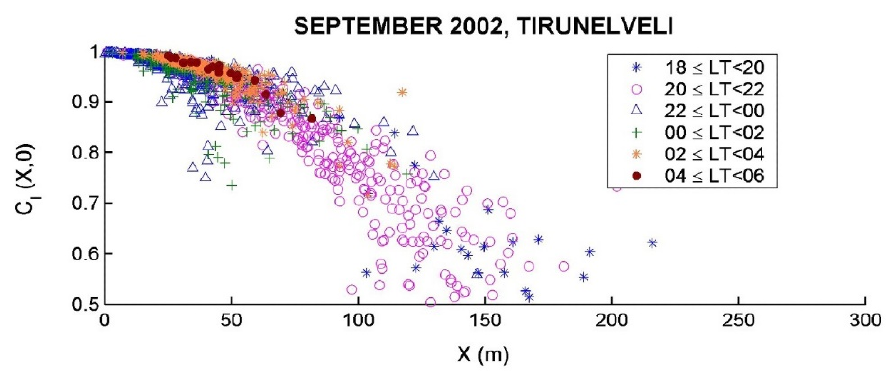
(cid:113) (cid:0) (cid:1) + V 2 V 2 , which is equivalent to a scatter plot 0 C